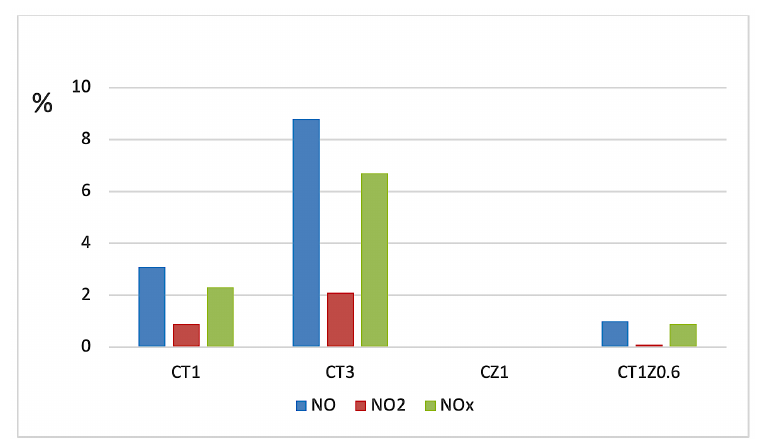
Figure 4. NO x removal under UV irradiation over CT1, CT3, CZ1 and